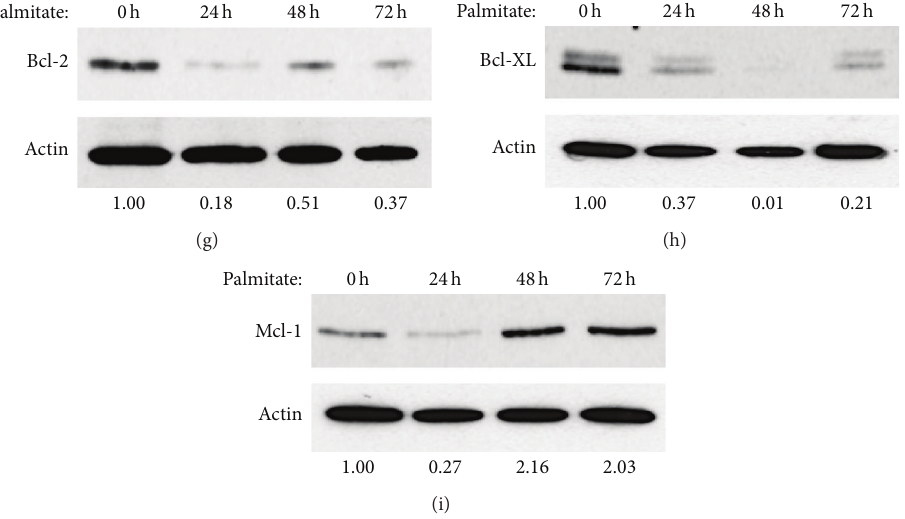
Figure 4: Palmitate and MG132 decrease levels of prosurvival proteins in pancreatic islets and 𝛽 -cells. ((a)–(c)) MIN6 cells were treated with 0.5 mM palmitate as indicated and expression of prosurvival proteins Bcl-2 (a), Bcl-XL (b), and Mcl-1 (c) was measured by Western blot. Band intensities were quantified and values of the specific time points standardised to 𝛽 -actin loading controls. Results are the means ± SEM of 3 independent experiments. ∗ 𝑃 < 0.05 , ∗∗ 𝑃 < 0.01 , and ∗∗∗ 𝑃 < 0.001 . ((d)-(e)) MIN6 cells were treated with 10 𝜇 M MG132 as indicated and expression of prosurvival proteins Bcl-2 (d), Bcl-XL (e), and Mcl-1 (f) was measured by Western blot. Band intensities were quantified and values of the specific time points standardised to 𝛽 -actin loading controls. Results are the means ± SEM of 3 independent experiments. ∗ 𝑃 < 0.05 ; ∗∗ 𝑃 < 0.01 . ((g)–(i)) Expression of prosurvival Bcl-2 proteins in mouse islets after palmitate treatment. Cell lysates were subjected to Western blotting with antibodies detecting Bcl-2 (g), Bcl-XL (h), and Mcl-1 (i). Quantification of protein bands is indicated at the bottom as a ratio to 𝛽 -actin loading control. The results are representative of two independent